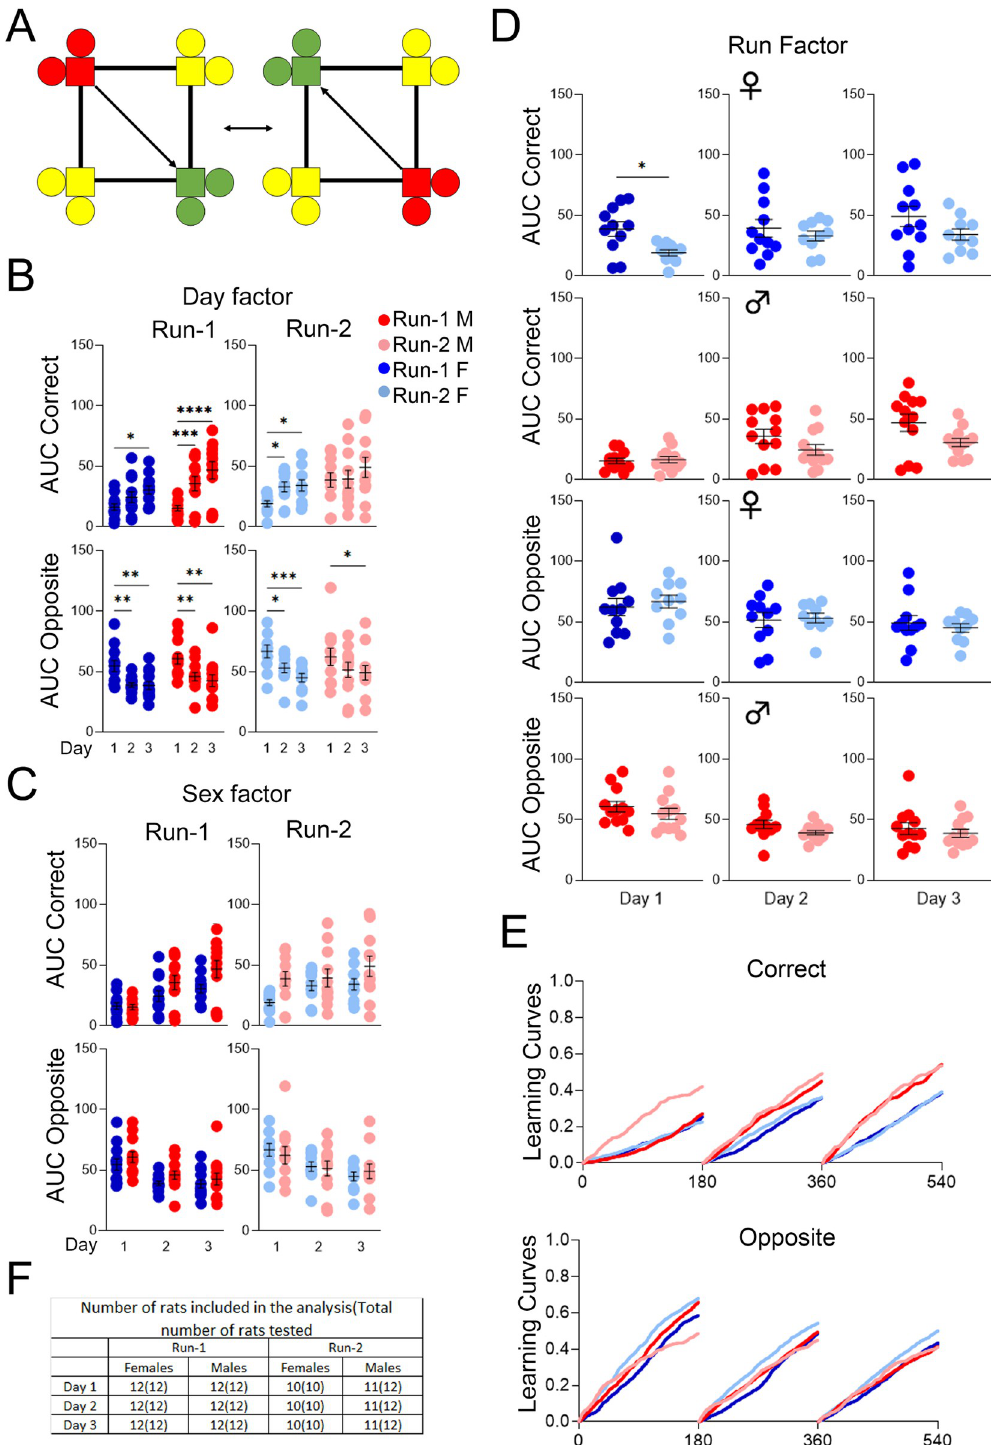
Fig 7. Behavioral sequencing, cohort A. (A) Example of correct (green), lateral (yellow), and opposite (red) corner layouts and pattern for a rat initially assigned to either corner 2 or 4. (B) Day factor, (C) Sex factor and (D) Run factor comparisons of area under the curve (AUC) for activity curves of individual animals by sex, program day, and Run, separated by visit categories (Correct or Opposite). (E) Activity curves showing the fractional accumulation (y-axis) of correct visits or opposite visits over drinking session time (x-axis), reset every 180 minutes, by sex and Run. (F) For Run-1, 12 male and 12 female rats